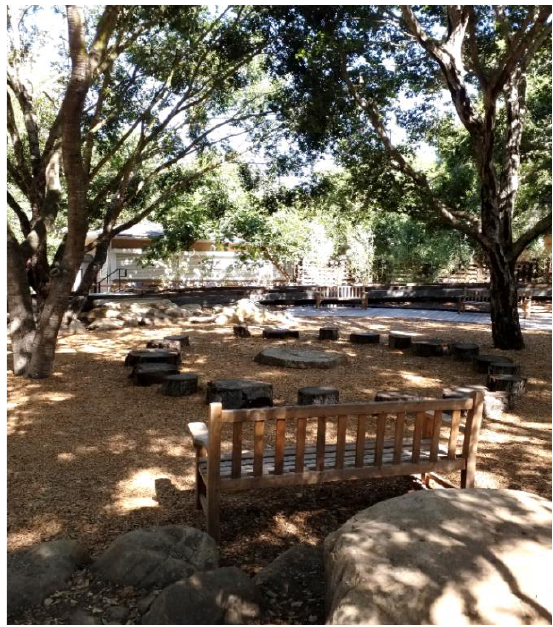
Figure 2. Stump circle and stage areas.